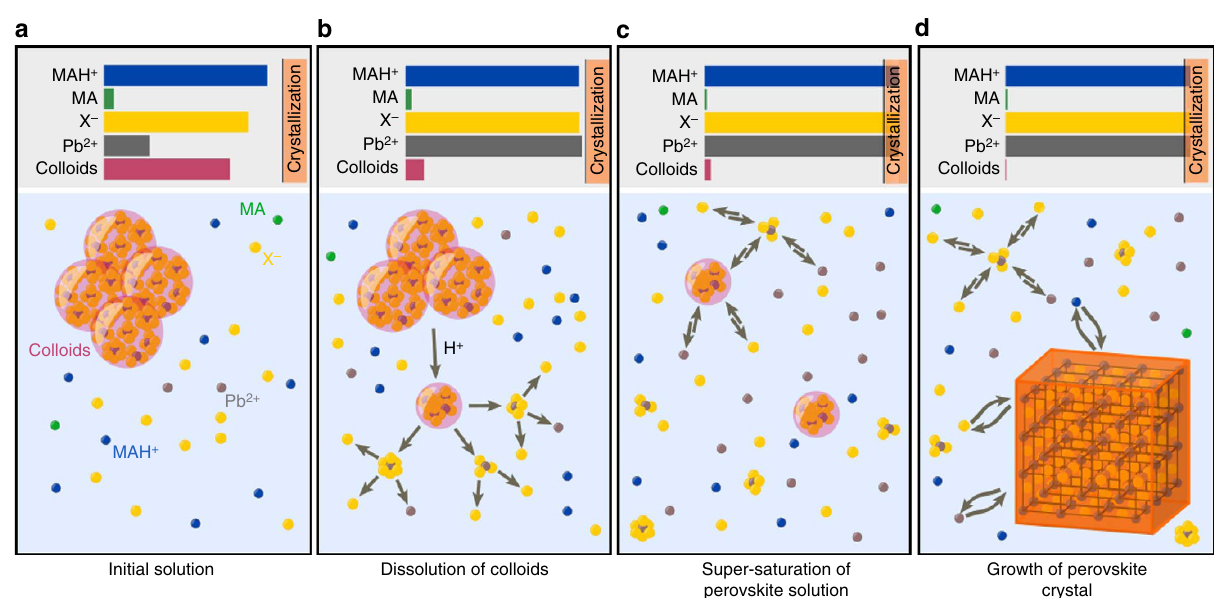
Figure 4 | Schematic representation of the crystallization mechanism. Horizontal bars on the top of each panel represent the concentration Pb 2 þ , X (cid:2) , MAH þ , MA and colloids (not to scale), and spheres with similar colour schematically represent each species in the bottom panel. The vertical bar in the top panel represents the regime for crystallization (that is, supersaturation). ( a–d ) show the sequence for the crystal